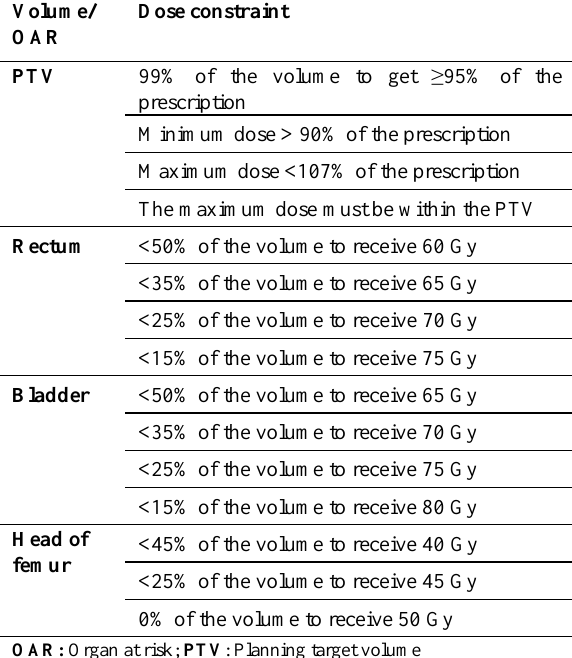
Table 1: Planning objectives for intensity modulated radiation therapy ( IMRT ) and